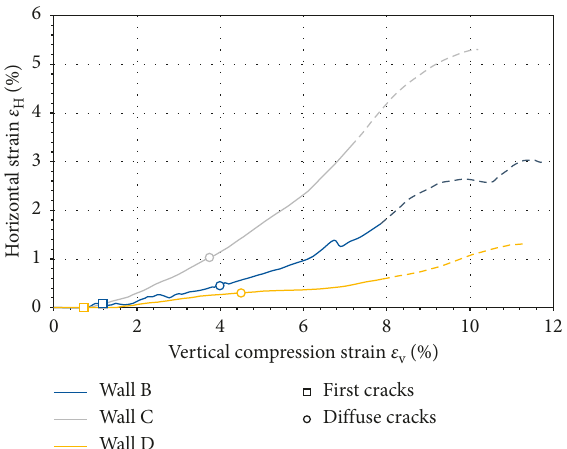
Figure 7: Horizontal strain-vertical strain diagrams for tested walls. On each curve, the point related to the formation of the first capillary cracks and those related to the formation of diffuse cracks are reported. The vertical and horizontal compression strains are computed by averaging the displacements measured by the two vertical and horizontal LVDTs, respectively. Post-peak behaviour (dotted lines) cannot be considered as completely reliable since test was force